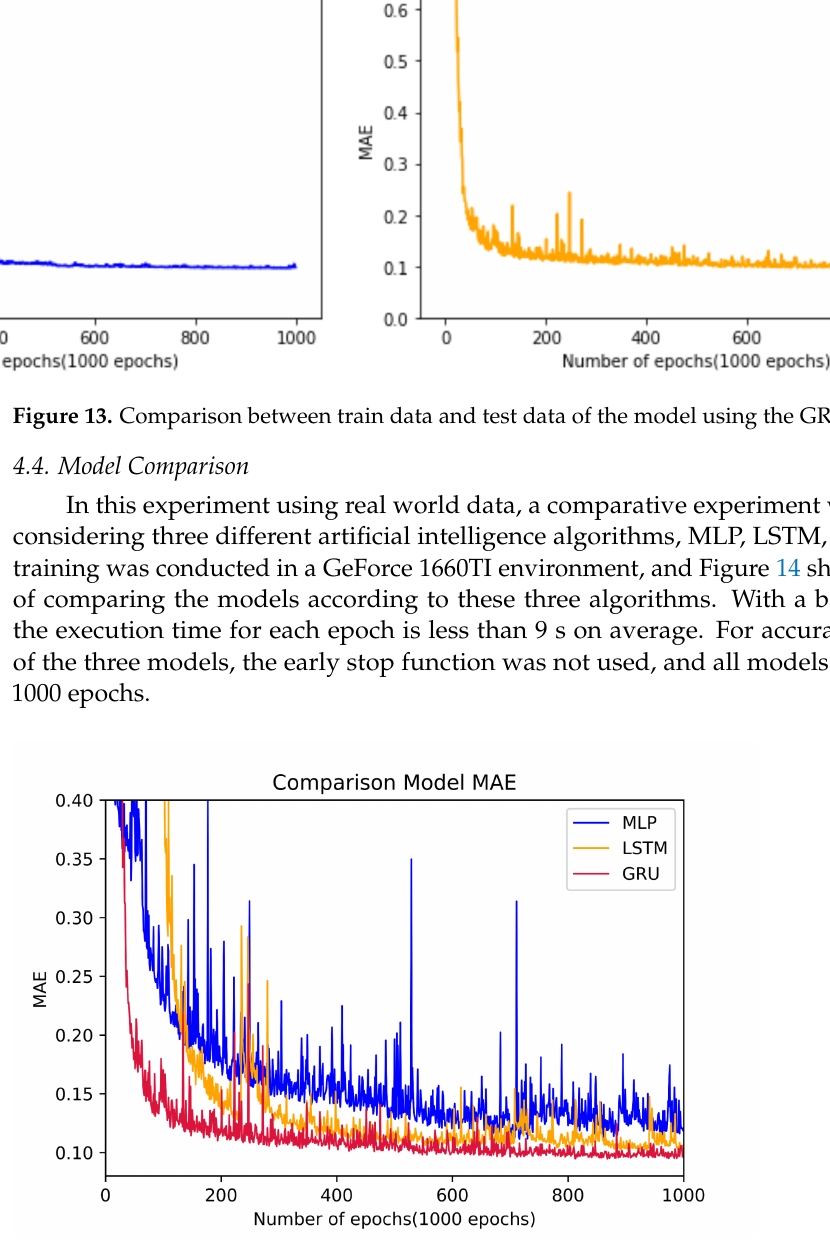
Figure 14. Comparing training